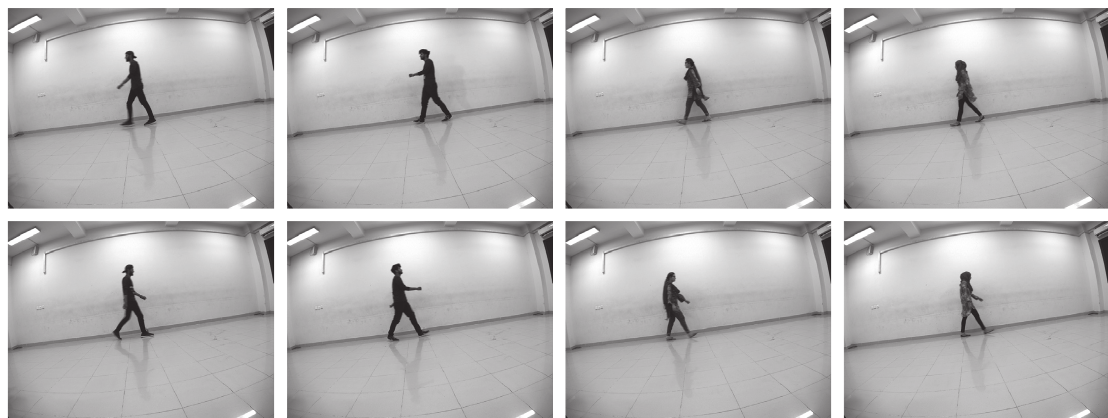
Figure 5: The subjects of SACV-Gait dataset are walking in L-R and R-L